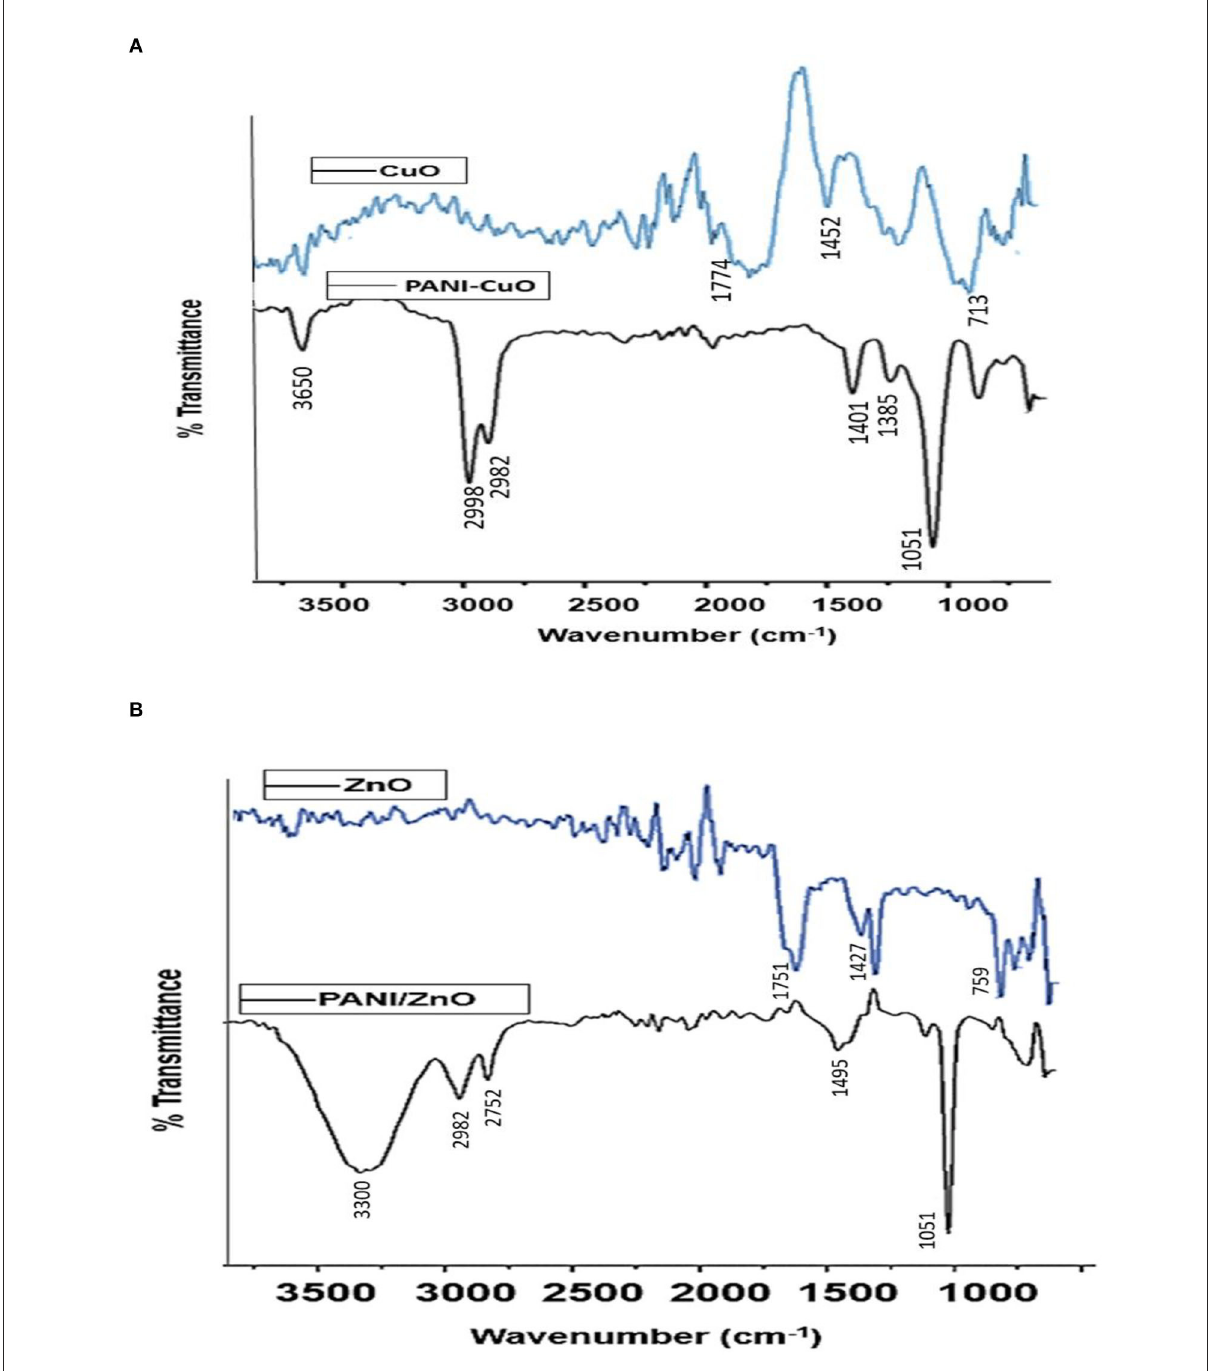
FIGURE3 FTIR spectra of (A) CuO and PANI/CuO NPs and (B) ZnO and PANI/ZnO NPs.